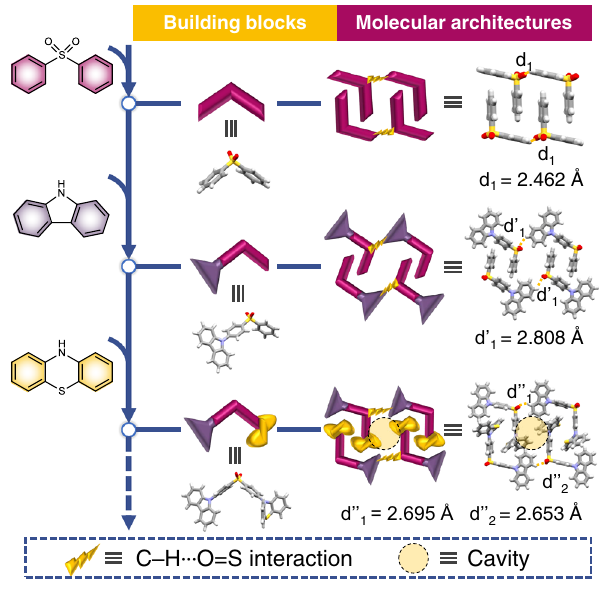
Fig. 1 | Design of the aggregate structure with dynamic URTP feature. The bottom-up design strategy for the dish-like molecular architecture constructed by organic building blocks through intermolecular